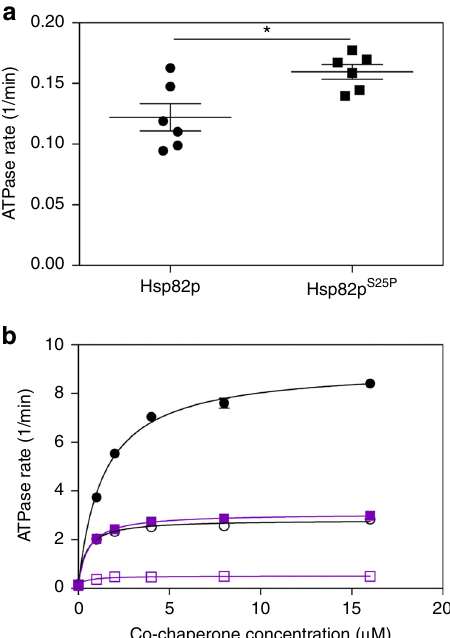
Fig. 6 Hsp82p S25P ATPase stimulation by Aha1p is dependent on the NxNNWHW motif. a The intrinsic ATPase activity of Hsp82p S25P is comparable to that of wildtype Hsp82p. Reactions contained 5 μ M Hsp82p or Hsp82p S25P ( n = 6). Statistical signi fi cance (*) was determined using an unpaired t -test. Error bars show standard error of the mean. b Stimulation of the ATPase activity of wildtype Hsp82p and Hsp82p S25P by increasing concentrations of Aha1p (closed black circles, open black circles, respectively) and Aha1p Δ 11 (closed purple squares, open purple squares, respectively). Reactions contained 1 μ M Hsp82p and indicated concentration of co-chaperone ( n = 3). Error bars show standard error of